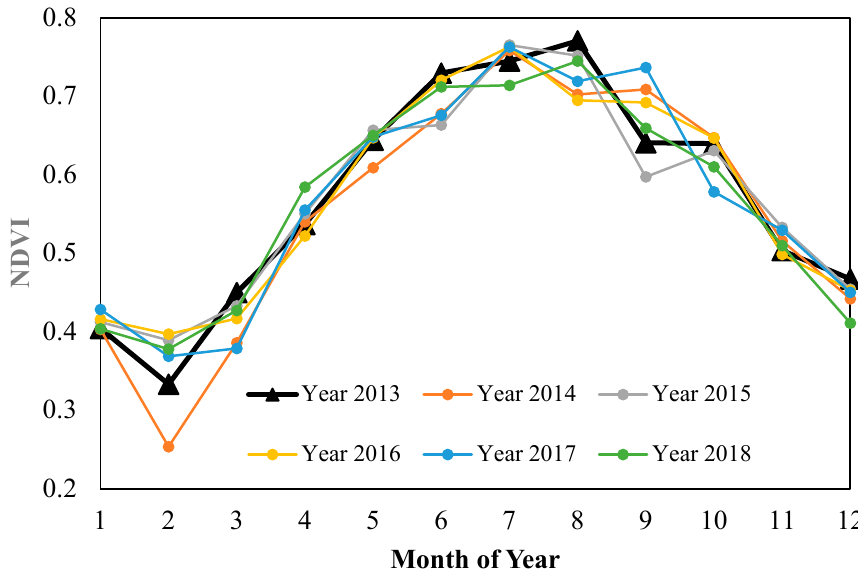
Figure 3. Intra-annul comparison between reconstructed (Year 2014 to 2018) and observed (Year 2013) NDVI of SPOT-VGT.